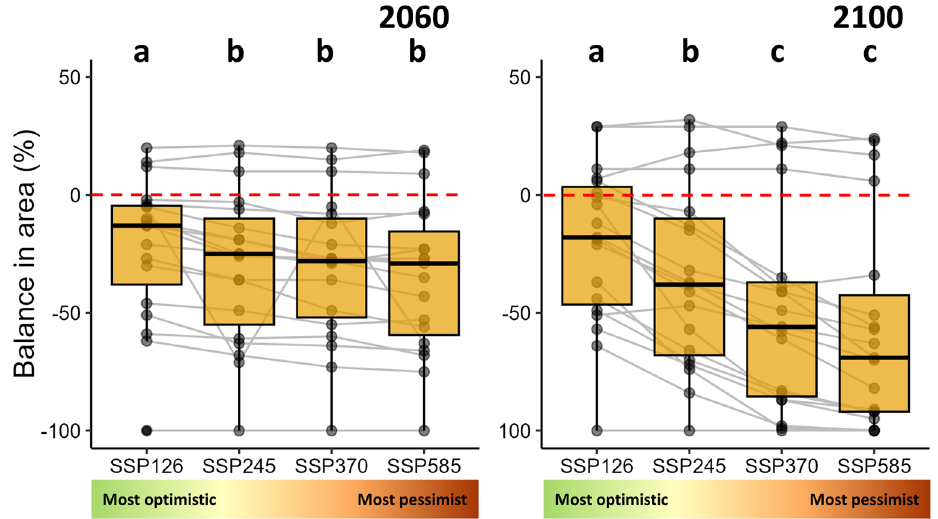
Figure 1. Balance in climatic suitability distribution area for Atlantic Forest endemic primate species (n = 19) in different Shared Socioeconomic Pathways (SSP1-2.6, the most optimistic one, SSP2-4.5, SSP3-7.0 and SSP5-8.5, the most pessimist one) for two times in the future (2060 and 2100) without considering potential dispersal. Balance (%) is the difference between area gain and area loss predicted and is proportional to the current climatic suitability distribution area. Negative values indicate a reduction, and positive values indicate a gain in distribution size predicted for the future. Medians, quartiles, and deciles are presented in boxplots. Post hoc results are represented by small letters (see detailed post hoc in Supplementary Table